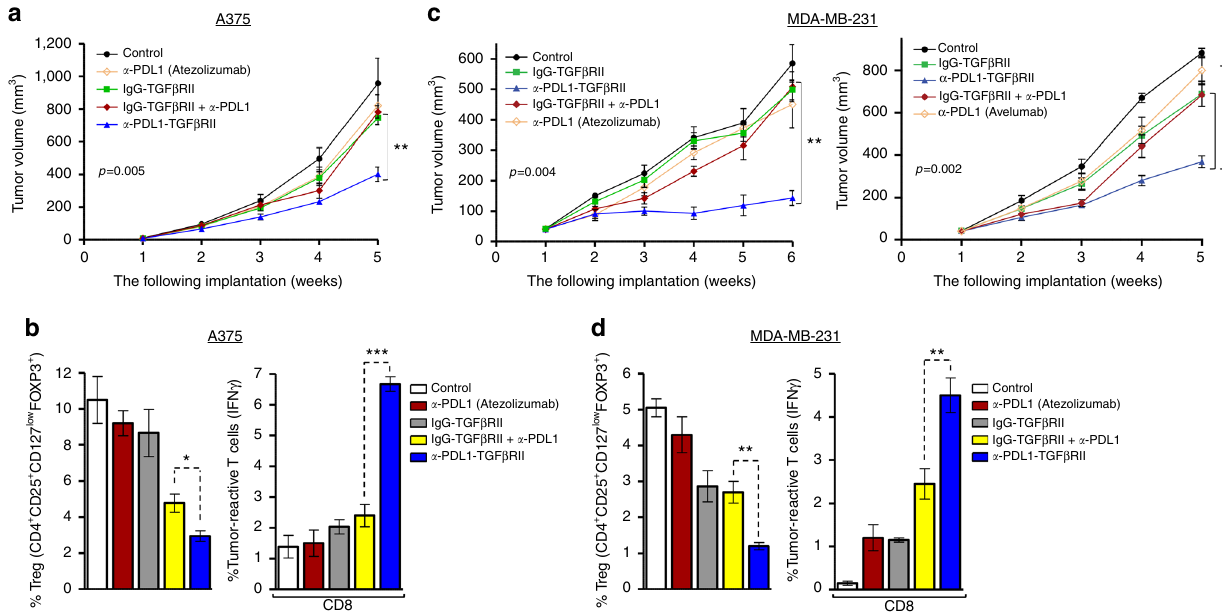
Fig. 7 a -PDL1-TGF β RII exhibits superior antitumor ef fi cacy compared to a -PD-L1 antibodies. Effect of the indicated treatments on melanoma and TNBC tumor xenografts in NSG mice reconstituted with human CD34 + HSC. Mice engrafted with human CD3 + cells were inoculated subcutaneously with either human melanoma (A375) or TNBC (MDA-MB-231-Luc) tumor cells. At 10d following tumor inoculation, mice were randomized into groups and treated i.p. with the indicated antibodies (5 mg kg − 1 weekly) or vehicle alone (untreated control). Tumor growth curves in A375 tumor-bearing mice ( a ) or MDA-MB- 231-Luc tumor-bearing mice ( c ) are shown (mean ± SEM of fi ve to six mice in each indicated group). In TNBC model, independent experiments were conducted to compare two different a -PDL1-TGF β RII antibody – ligand traps with their respective a -PD-L1 antibodies, Atezolizumab ( c , left) (and Avelumab ( c , right). b , d Flow cytometric analysis of the comparative in vivo effect of the indicated treatments on in fi ltrating FOXP3-expressing Tregs and tumor-reactive IFN- γ -expressing CD8 + T cells in melanoma ( b ) and TNBC ( d )